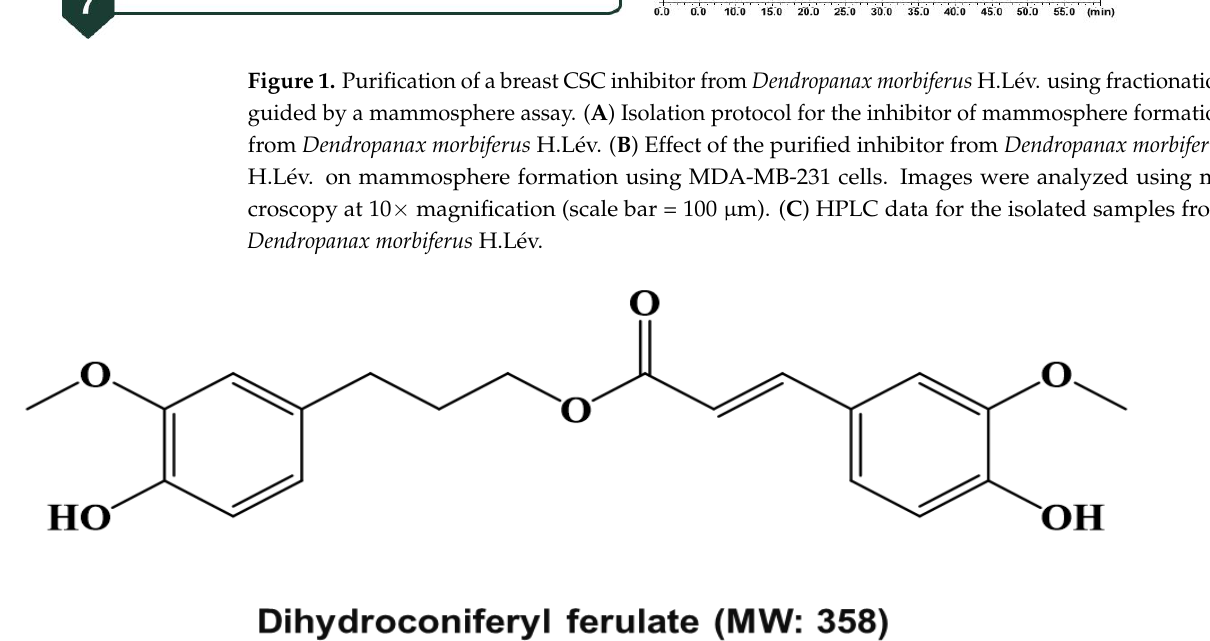
Figure 2. Molecular structure of the cancer stem cell inhibitor from Dendropanax morbiferus H.Lév. To determine whether dihydroconiferyl ferulate has a potent inhibitory effect on hu- man breast cancer cells, we first tested the anti-proliferative effect on dihydroconiferyl ferulate at various concentrations in MCF-7 and MDA-MB-231 cells. Dihydroconiferyl fer- ulate inhibited the proliferation of MDA-MB-231 (Figure 3A) and MCF-7 (Figure 3B) cells at 75 µM. The IC50 value (the drug concentration required for 50% growth reduction in